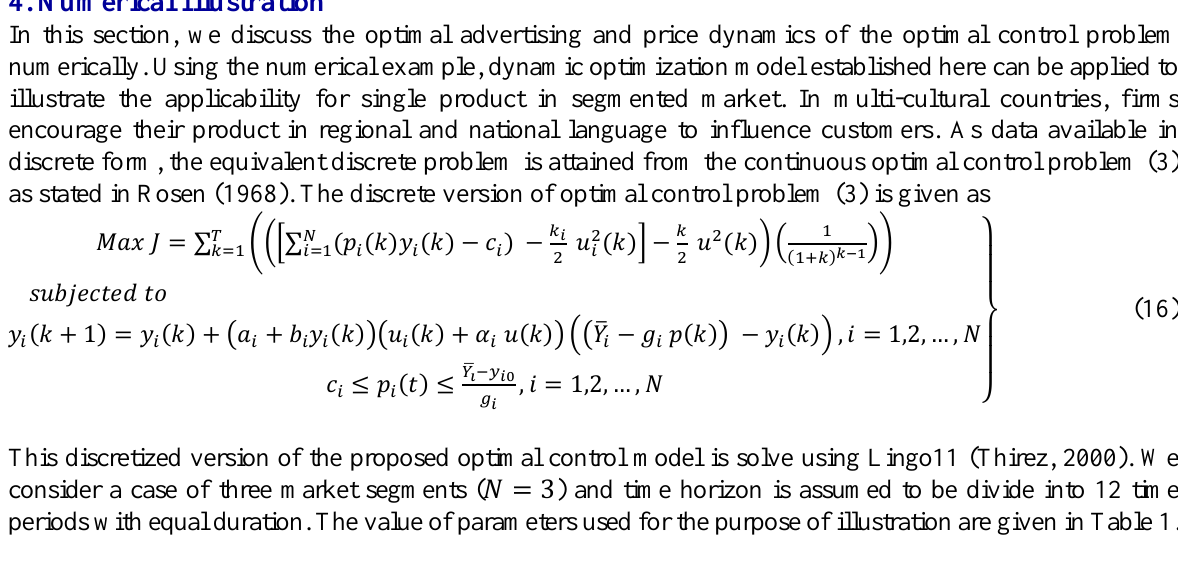
Table 1. The values of